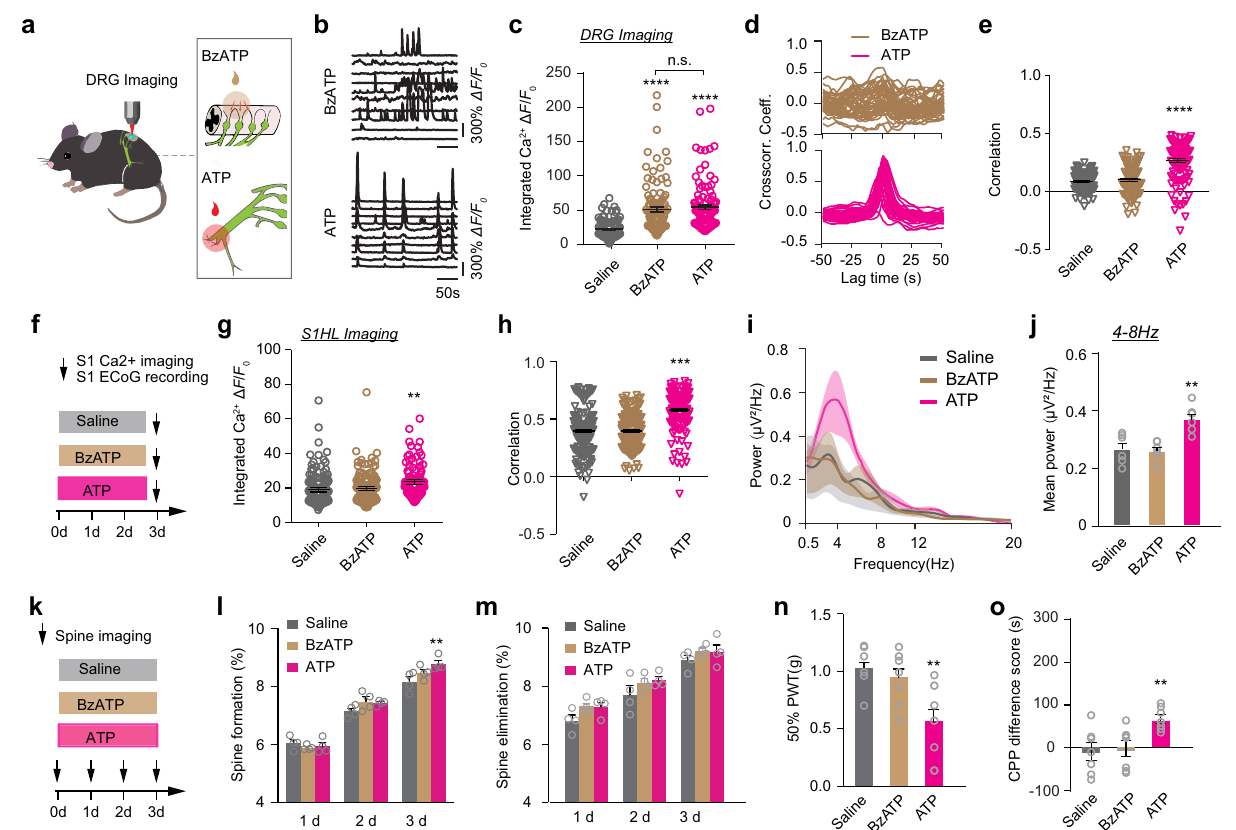
Fig. 6 | Increased DRG synchrony elicits S1 plasticity and pain-like behavior in naivemice.a Schematic ofperipheral BzATPorATP application. b Representative fl uorescencetracesofDRGneuronswithapplicationofBzATPorATP. c Integrated Ca 2+ activityoftheDRGneuronsinducedbylocalapplicationof500 μ MBzATPwas comparable to that induced by peripheral application of 10mM ATP. d Cross- correlograms of the same 10 neurons after BzATP (top panel) and ATP application (bottom panel). e Correlation coef fi cient of DRG neurons before and after ATP or BzATP application in naive mice. f Schematic of experimental design. In vivo Ca 2+ imaging of L2/3 pyramidal neurons and ECoG recording were performed in S1 of naivemicetreatedwithsaline,BzATP,orATPfor3days. g , h IntegratedCa 2+ activity ( g ) and correlation coef fi cient ( h ) of L2/3 pyramidal neurons in naive mice after repeatedsaline,BzATP,or ATP treatment. i , j ECoG power spectra( i ) and the theta